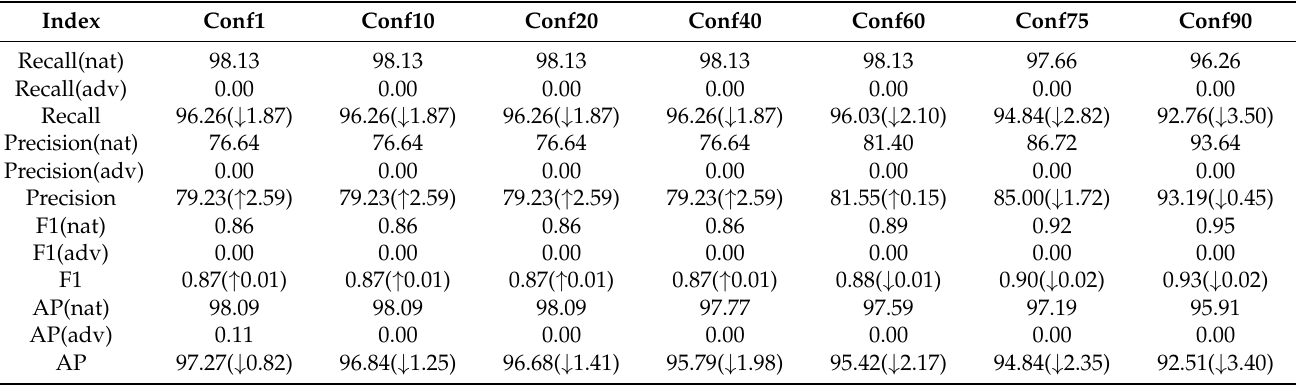
Table 2. The detection performance of the YOLOv4 without our defense algorithm on clean images and the adversarial patch attack, and the detection performance of the YOLOv4 with our defense algorithm under the adversarial patch